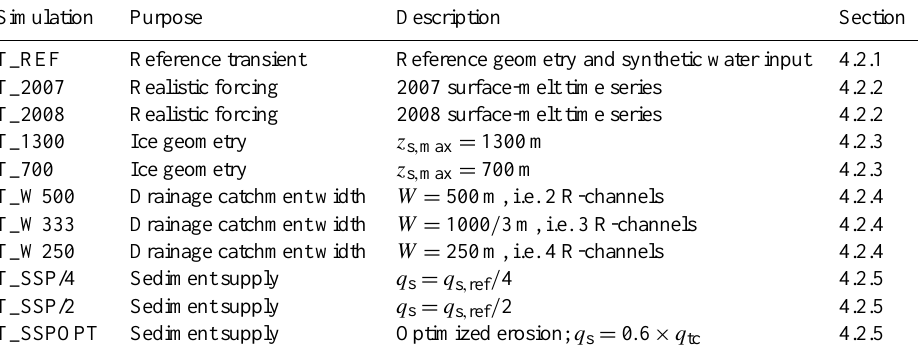
Table 4. Summary of transient simulations. In this series of simulations the basal sliding speed is u b = 5ma − 1 and the reference sediment supply is q s , ref = 9 . 1 × 10 − 3 m 2 s − 1 (Table 2). Water is fed to the network of cavities rather than the channel, hence ˙ b ch = 0ms − 1 , and the function of surface elevation is that of the steady-state simulations (Table